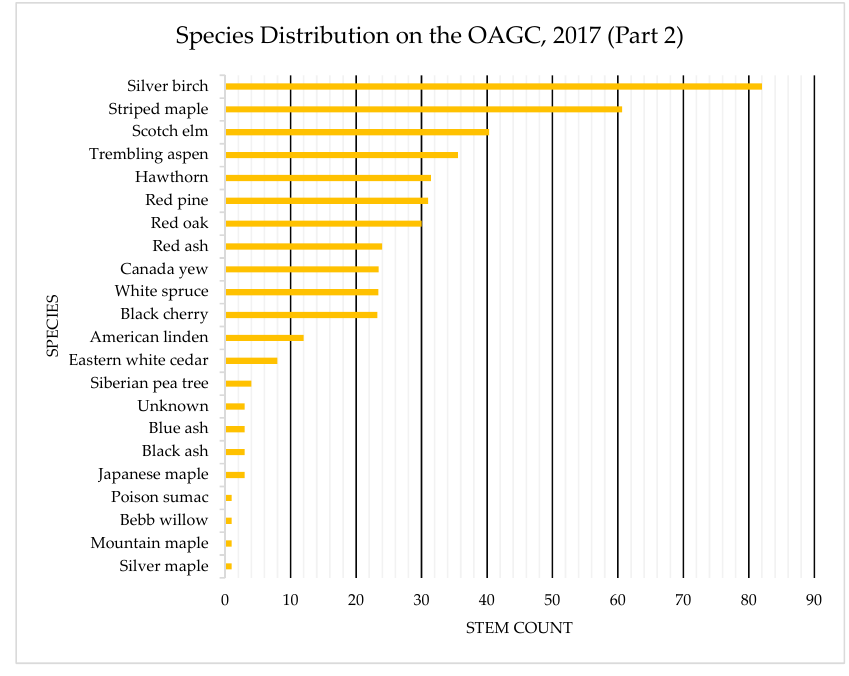
Figure A2. Total tree species distribution on OAGC, 2017 (lesser frequency) based on plot projections made using the area of forested patches.